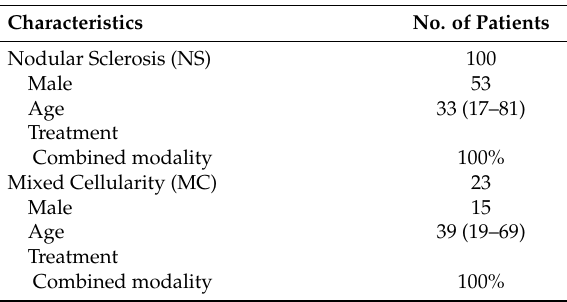
Table 3. Characteristics of the HL